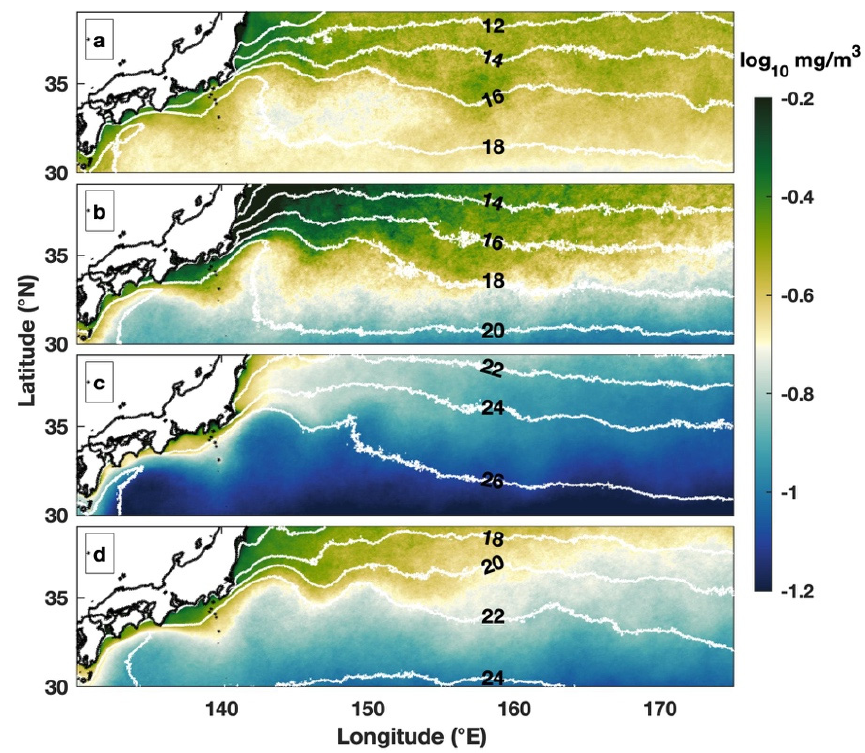
Figure 3. Seasonally averaged Chl-a (log 10 (mg/m 3 )) overlaid with SST ( ◦ C). The seasons are ( a ) winter (January–March), ( b ) spring (April–June), ( c ) summer (July–September), and ( d ) fall (October–December).